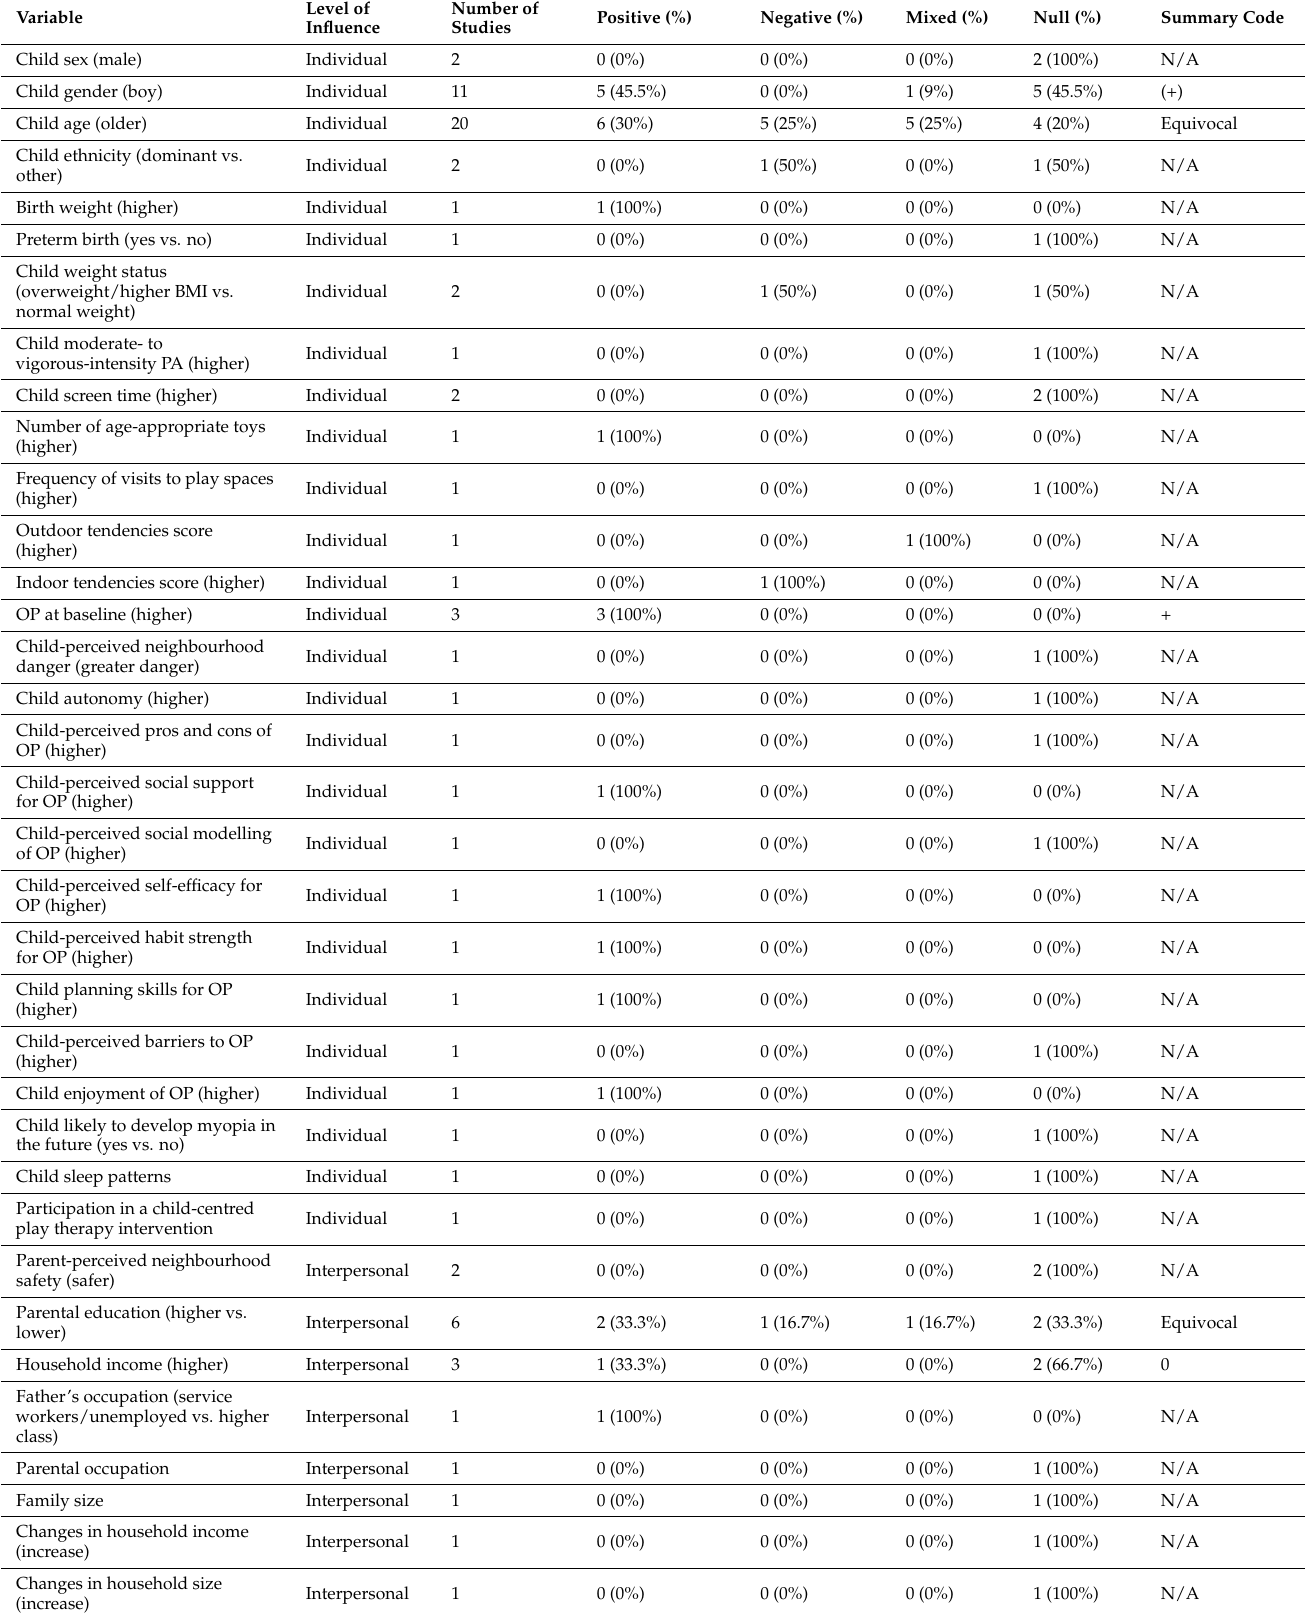
Table 3. Summary of the determinants of outdoor time in children and